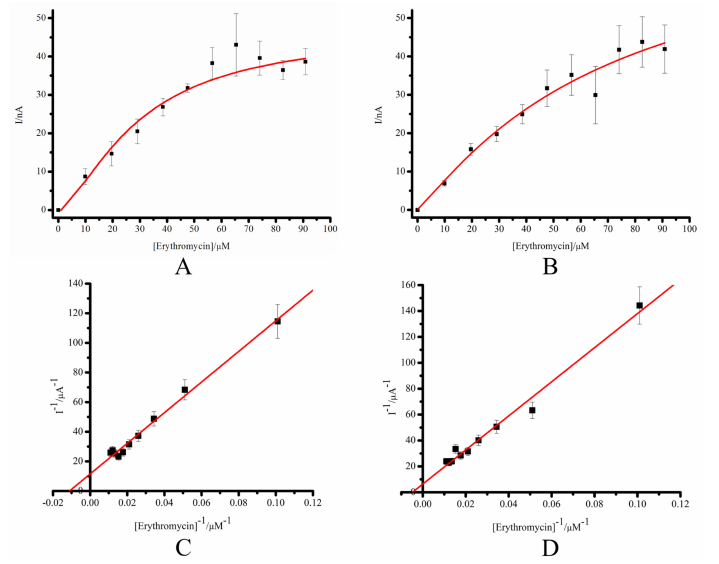
Figure 4. Michaelis–Menten plot of the dependence of the catalytic current of SPE/DDAB/CYP3A4 ( A ) and SPE/DDAB/SLO/CYP3A4 ( C ) on erythromycin concentration 10–100 µ M; ( B ) the Lineweaver–Burk plot for SPE/DDAB/CYP3A4 and SPE/DDAB/SLO/CYP3A4 ( D ). Titration of CYP3A4 was performed with 10 mM erythromycin dissolved in ethanol. The ethanol concentration in the cell did not exceed 1% by volume. The measurements were carried out in 1 mL of potassium phosphate buffer at a fixed working electrode potential of − 0.5 V (vs. Ag/AgCl). The values are the means from at least 3 experiments ±